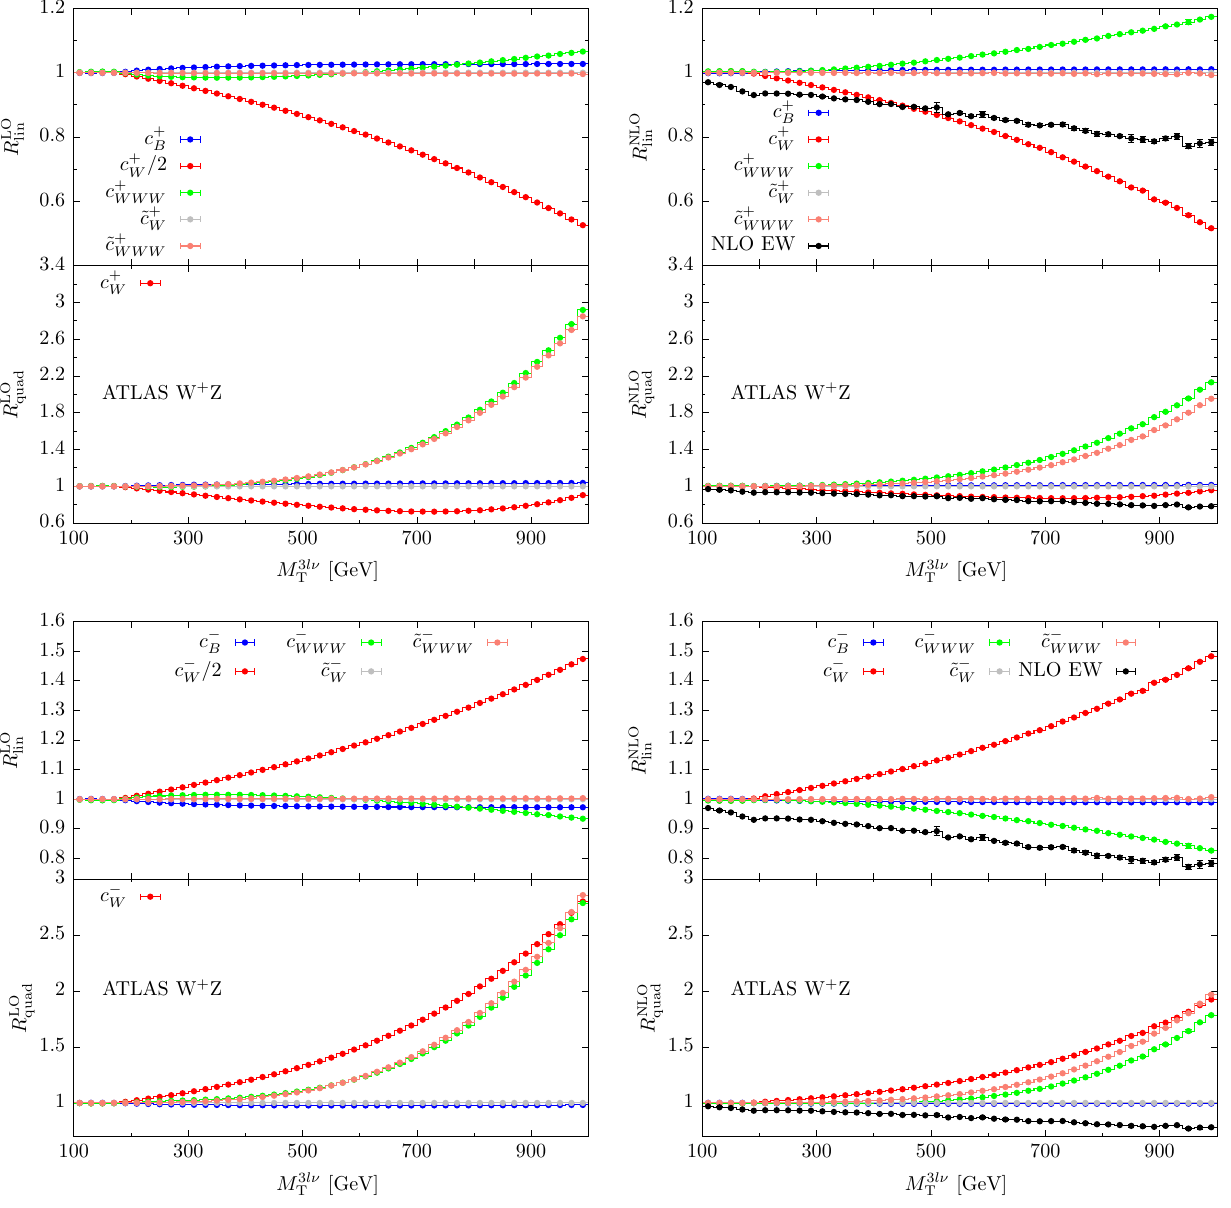
Fig. 14 Ratio R LO ( NLO ) as a function of the WZ transverse mass for lin ( quad ) the process pp → e + ν e μ + μ − in the ATLAS setup of Eq. (4.7). Same notation and conventions as in Fig. 7. In order to improve the plot read-